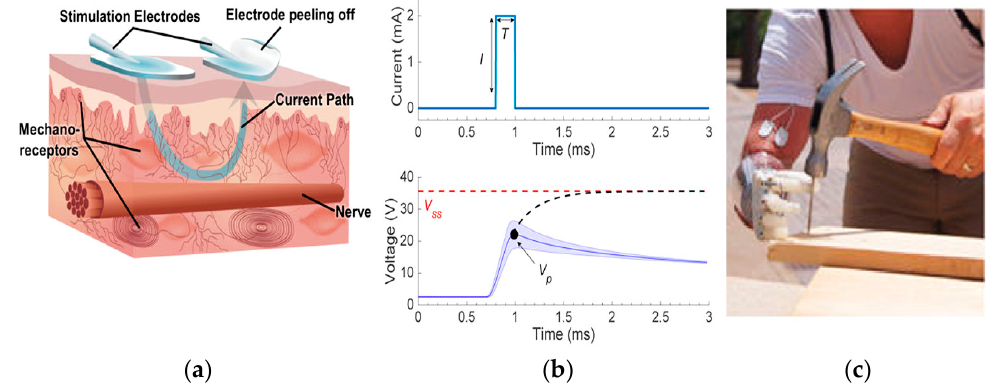
Figure 7. Operating principle of neural stimulation-based tactile interfacing system. Schematic depicting the mode in which electric current excites the nerve to produce electro-tactile sensations ( a ) using pulsed signals ( b ); an example of prosthesis based on neural stimulation tactile where feedback intensity is steadily controlled when an amputated user pounds a nail ( c ) [45].